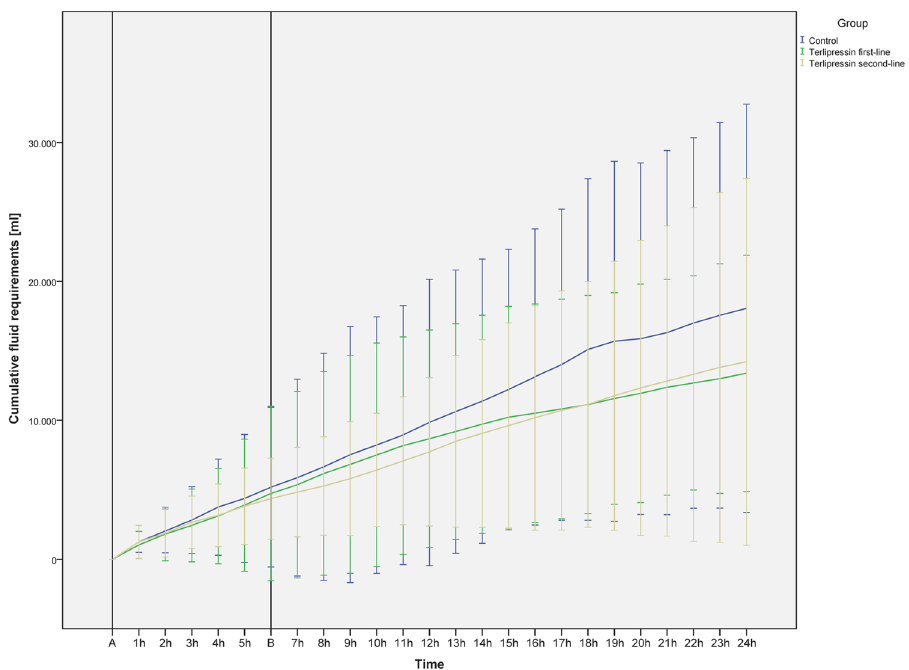
Figure 3. Cumulative fluid requirements per hour. The figure demonstrated the cumulative fluid requirements of the study animals over time within the 24-hour interventional period. The average initiation-points of the study solutions are highlighted in the figure. (A) Shock time and initiation of the 1 st study solution. (B) Average start of the 2 nd study solution. Data are presented as mean [standard deviation].